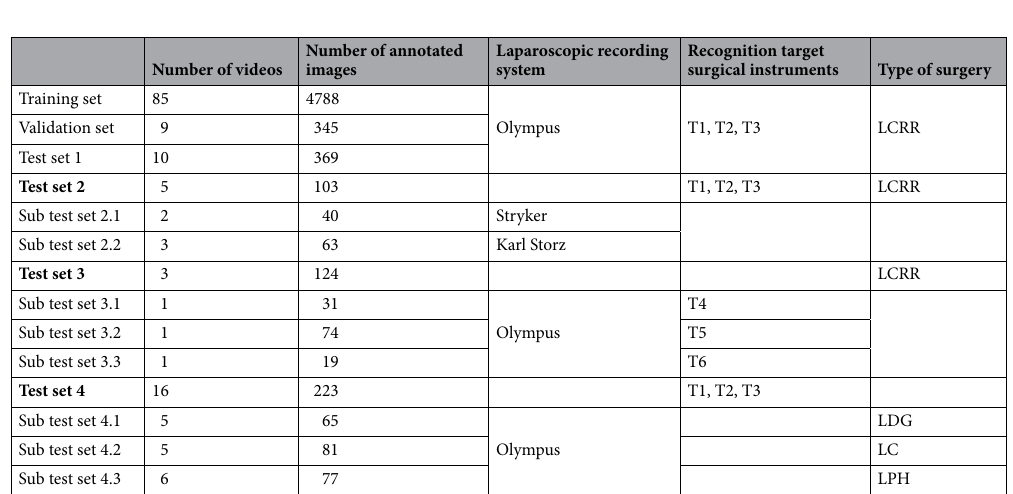
Table 1. Dataset characteristics. T1 harmonic shears, T2 endoscopic surgical electrocautery, T3 Aesculap AdTec atraumatic universal forceps, T4 Maryland, T5 Croce-Olmi, T6 needle holder; LCRR laparoscopic colorectal resection, LDG laparoscopic distal gastrectomy, LC laparoscopic cholecystectomy, LPH laparoscopic partial hepatectomy.